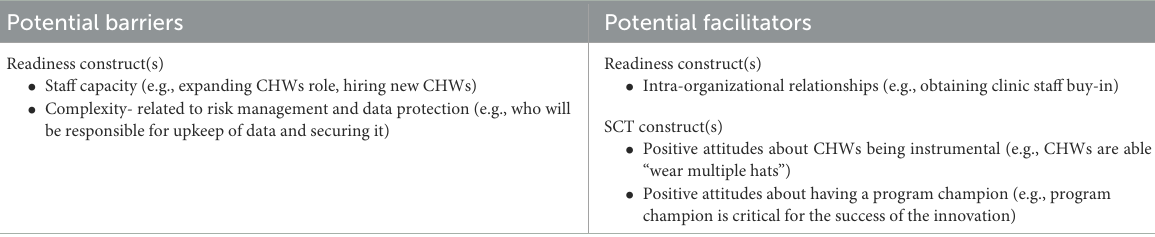
TABLE 2 Example findings of leadership barriers and facilitators from rapid qualitative analysis.